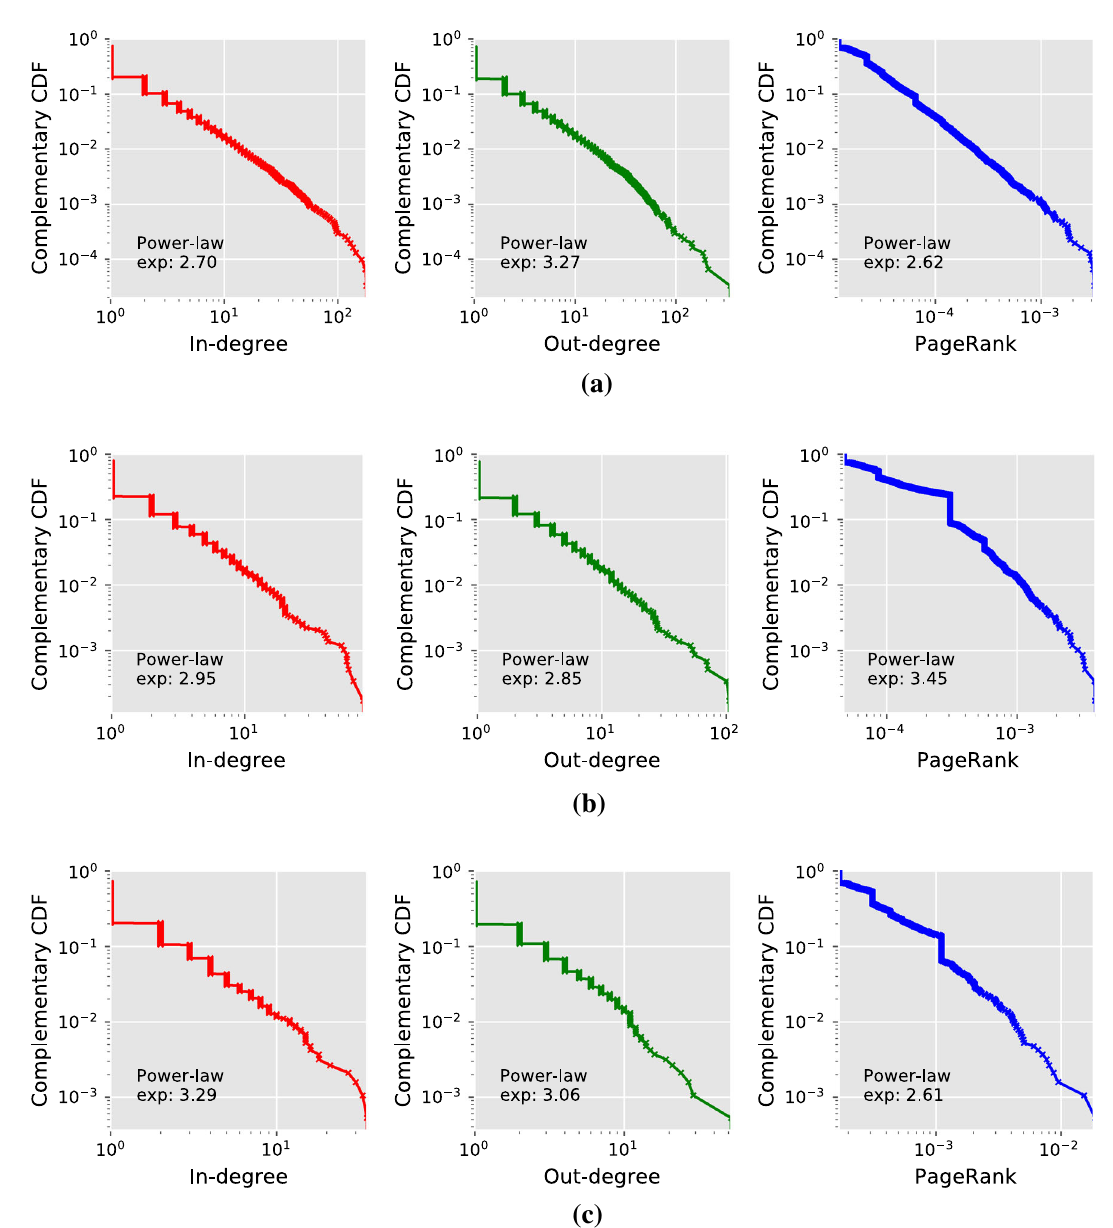
Fig. 13 Centrality distribution of job hop graph. a Singapore. b Switzerland. c Hong